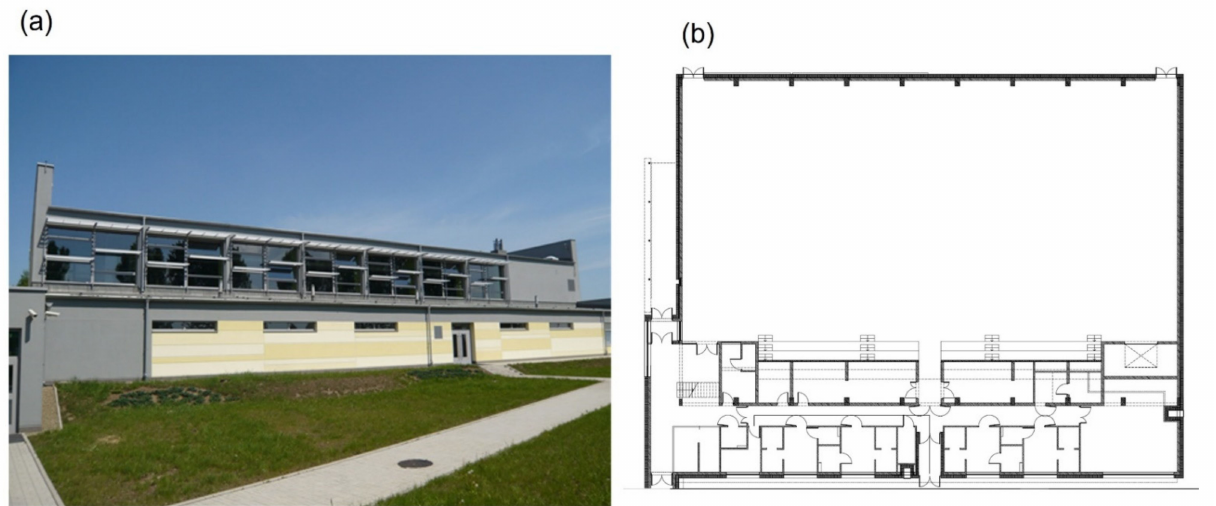
Figure 1. Passive hall in Słomniki, south façade ( a ) (author’s archive), and ground floor plan ( b )